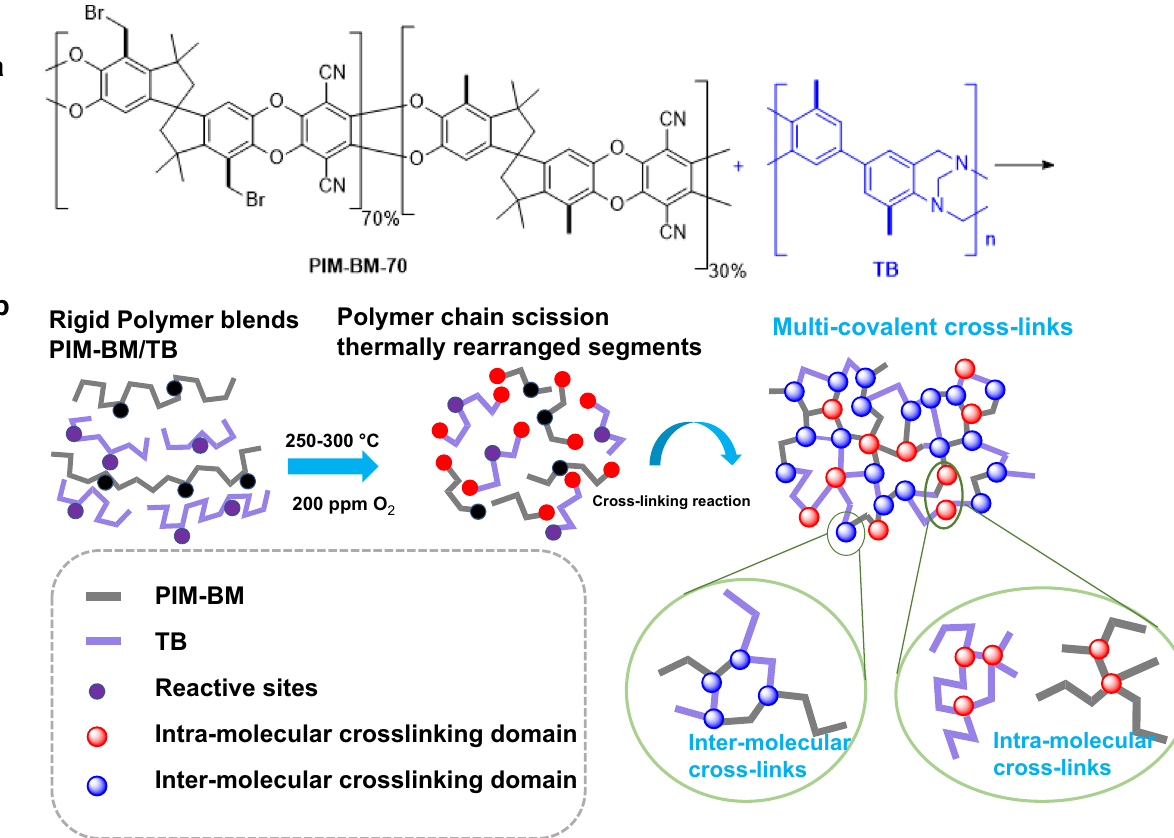
Fig. 1 Schematic of crosslinking reactions between PIM-BM and TB. a Chemical structure of PIM-BM and TB. b Proposed crosslinking mechanisms between PIM-BM and